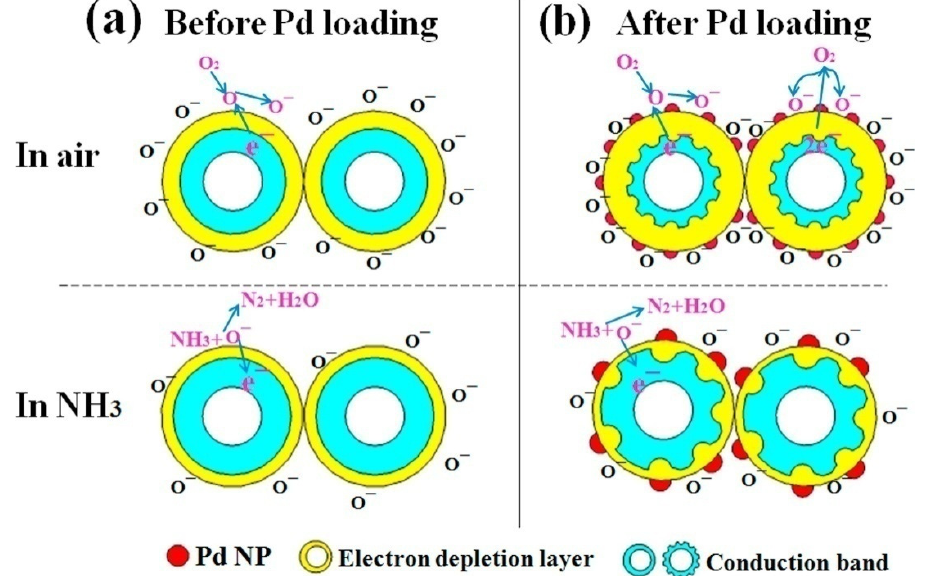
Figure 7. Mechanism diagram of PSi/WO 3 /Pd to NH 3 : ( a ) Before Pd loading, ( b ) After Pd loading [139].